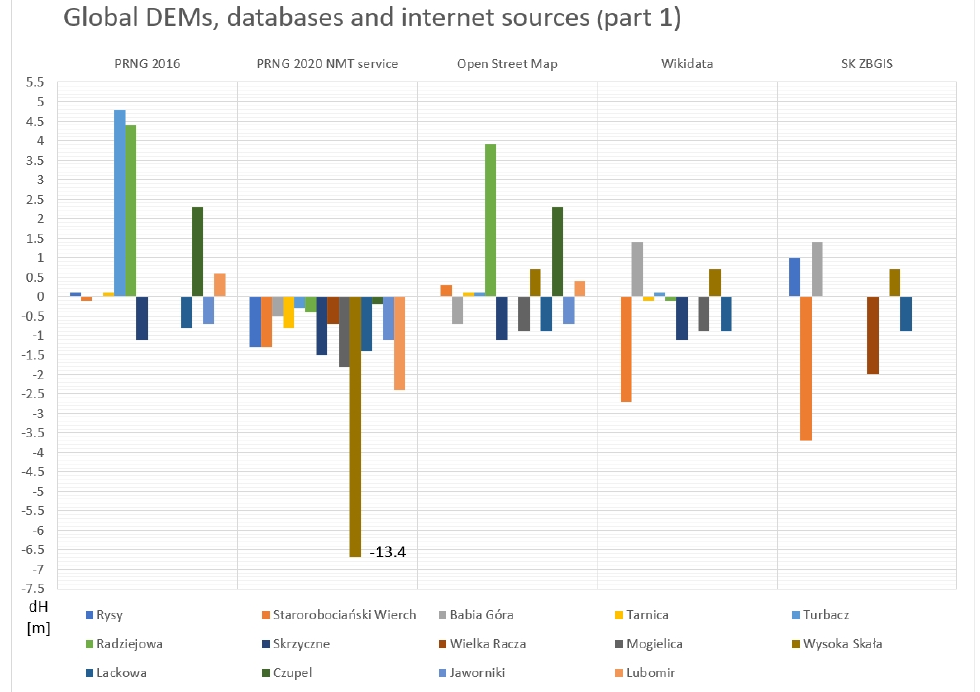
Figure A2. Height difference with GNSS surveying for Global DEMs, databases, and Internet sources (part 1). Source: authors.